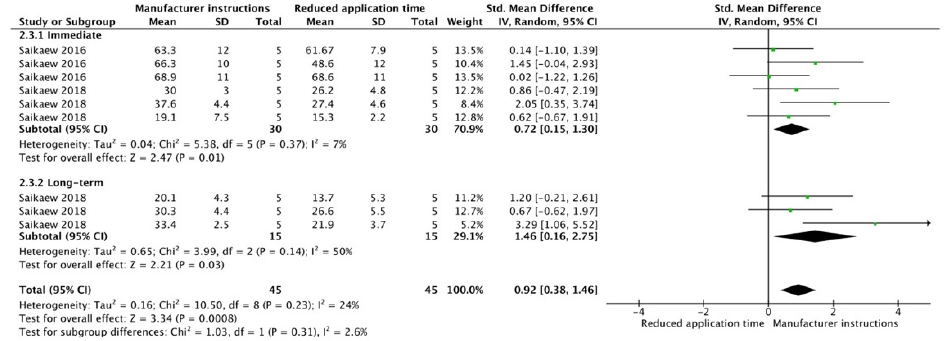
Figure 14. Forest plot showing the bond strength values when the adhesive was applied with reduced application time.